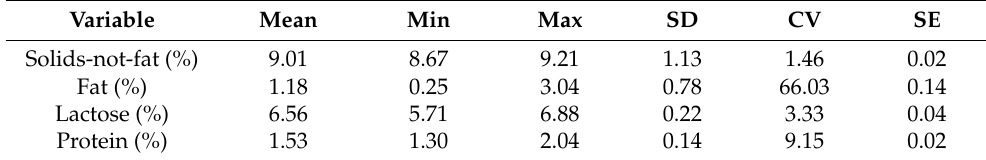
Table 1. The chemical composition of mare’s milk. Variable